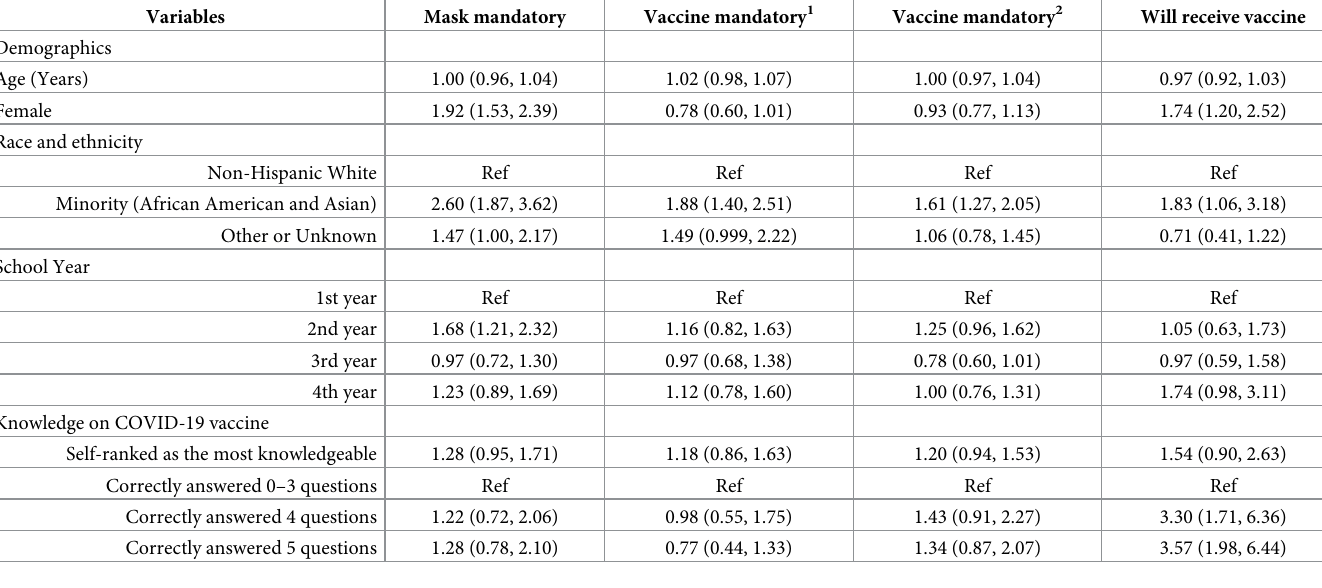
Table 3. Odds ratios and 95% confident intervals from the multiple regression of attitude on demographics and knowledge on COVID-19